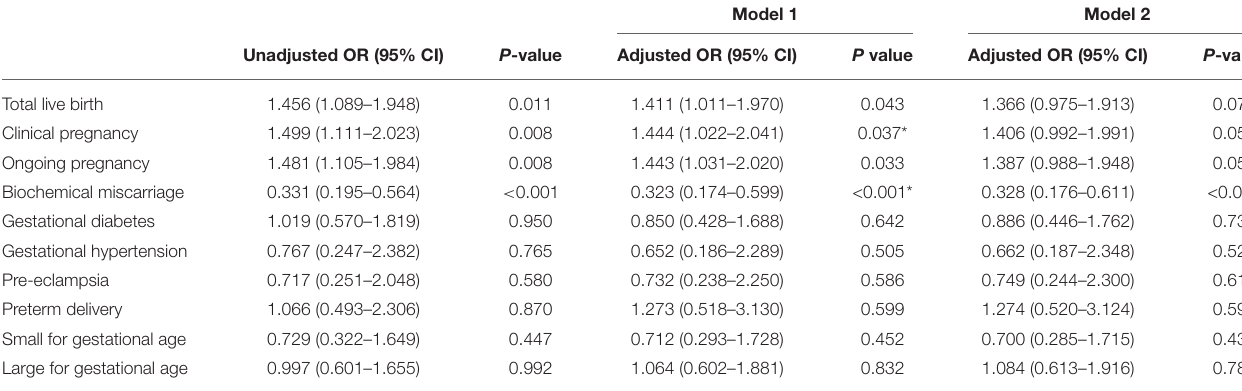
TABLE 4 | Logistic regression for the effect of natural cycle vs. HRT cycle regimen on obstetric